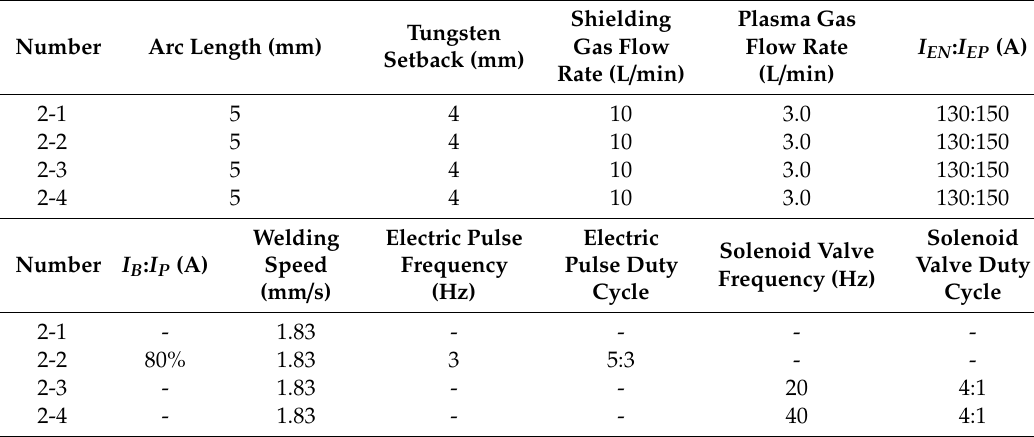
Table 2. Parameters for weld-forming experiments.